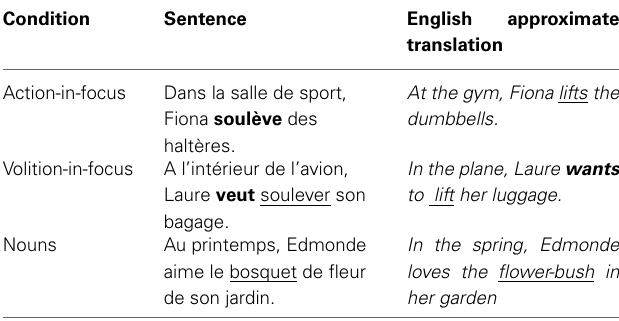
Table 1 | Example of stimuli used in the Experiment 1 and their approximate English